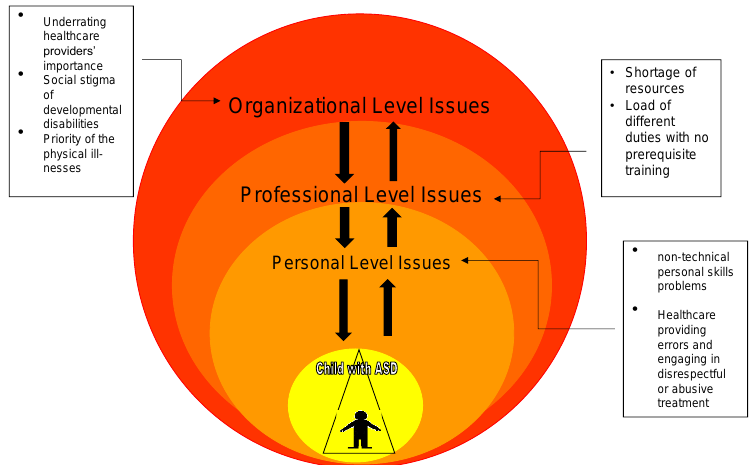
Figure 1. Impacts of the three considered organizational, professional, and personal factors in the healthcare provision system for individuals with ASD and their families in the